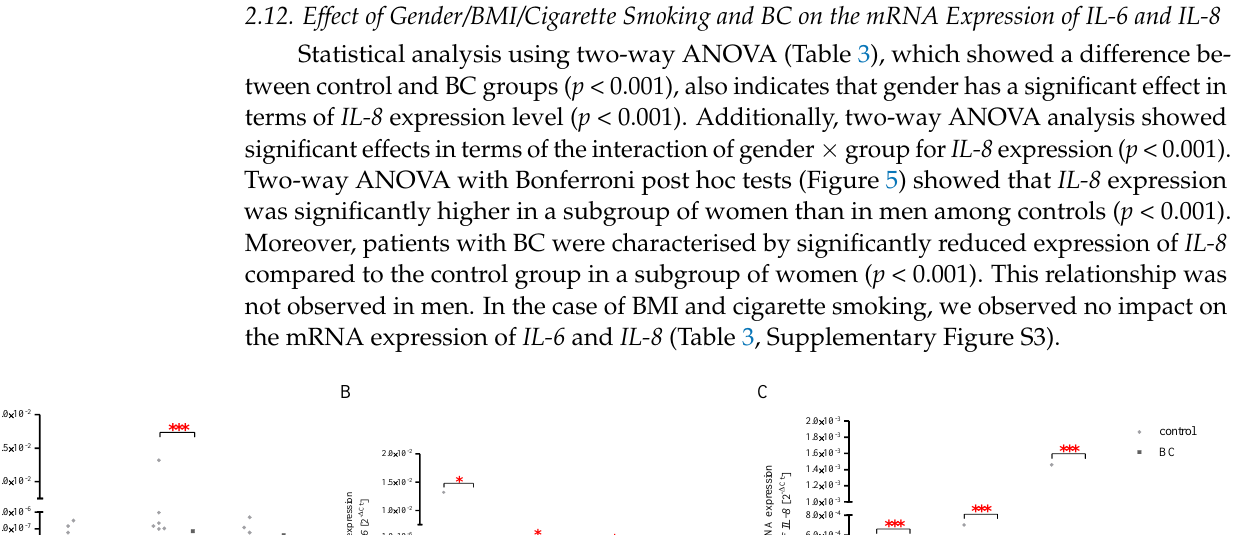
Figure 3. Basic IL-6 and IL-8 expression in primary tumour size groups ( A , B ), the status of lymph nodes ( C , D ), and distant metastasis ( E , F ), expressed using the 2 −ΔCt (C t gene − C t 18S ) method for each sample. The data are plotted as individual values and the median with interquartile range is indicated by the horizontal bars; *— p < 0.05; **— p < 0.01.